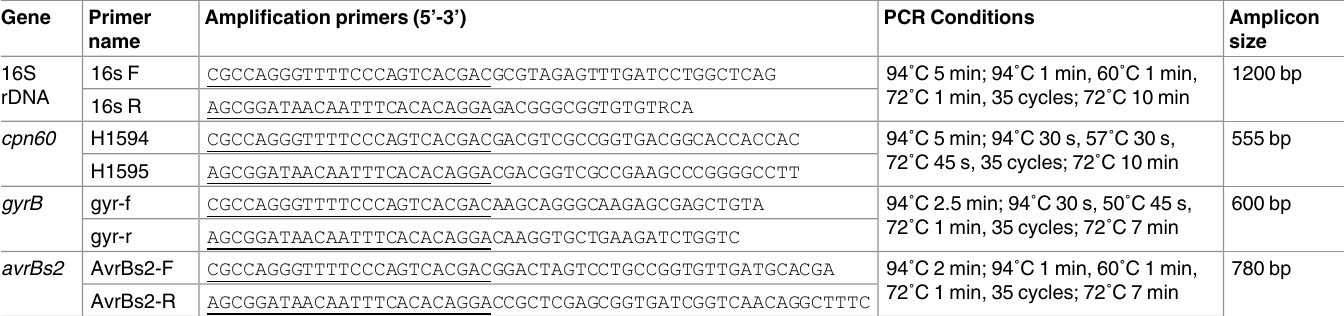
Table 1. Primers and PCR conditions used for DNA sequence amplifications in this study.